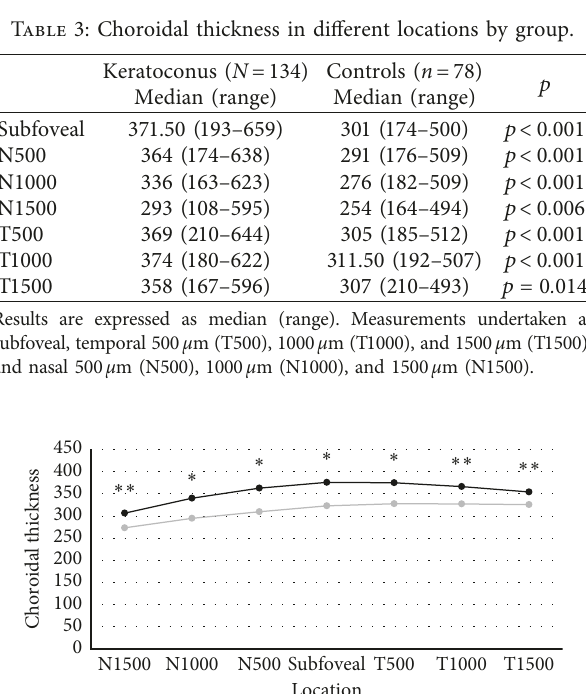
Figure 2: Mean choroidal thickness in each group along a hori- zontal section, measured in microns. ∗ p < 0 . 001; ∗∗ p < 0 .